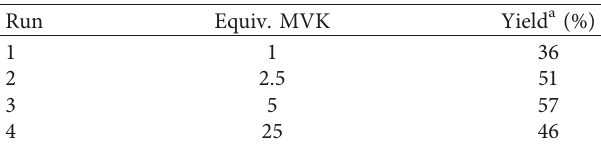
Experimental conditions: anode � Fe; cathode � Ni grid (surface area � 30cm 2 ); current intensity I � 0.1A; solvent � DMF+TBABr